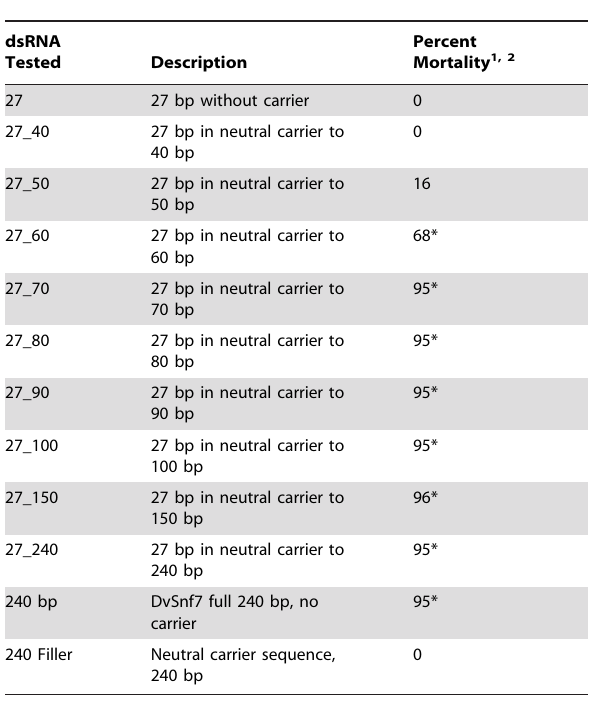
Table 2. Summary of synthesized dsRNA used to determine the biological activity of different sized molecules at an exposure concentration of 23 ng DvSnf7 dsRNA/mL in 12-day diet bioassays with Southern Corn Rootworm, (SCR, Diabrotica undecimpunctata howardi ).